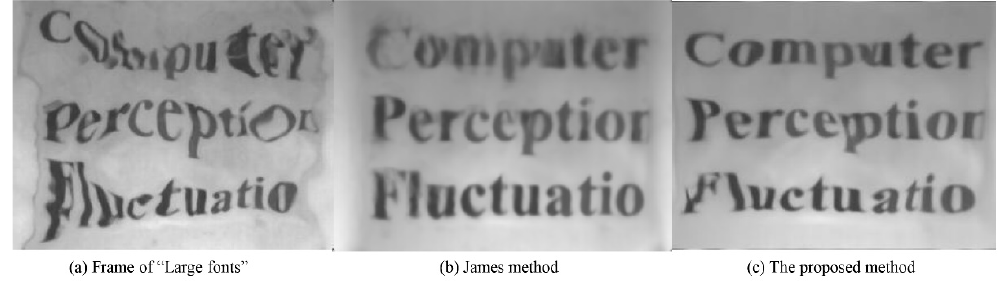
Figure 8. The comparison between the proposed method and the James method [24]. ( a ) One frame of the original data set. ( b ) The result recovered by the James method. ( c ) The result recovered by the proposed method.